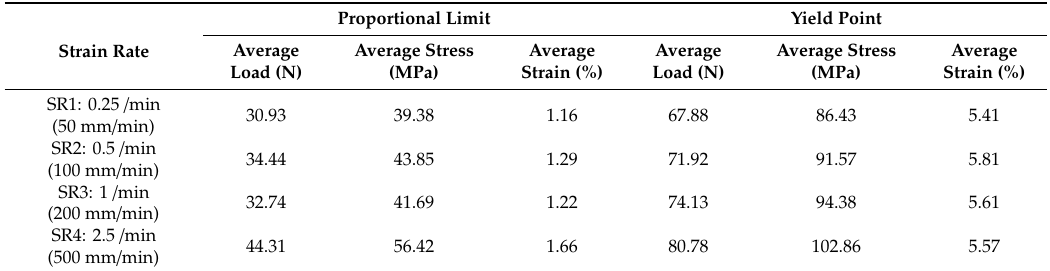
Table 3. Average results from a minimum of three samples at each strain rate.